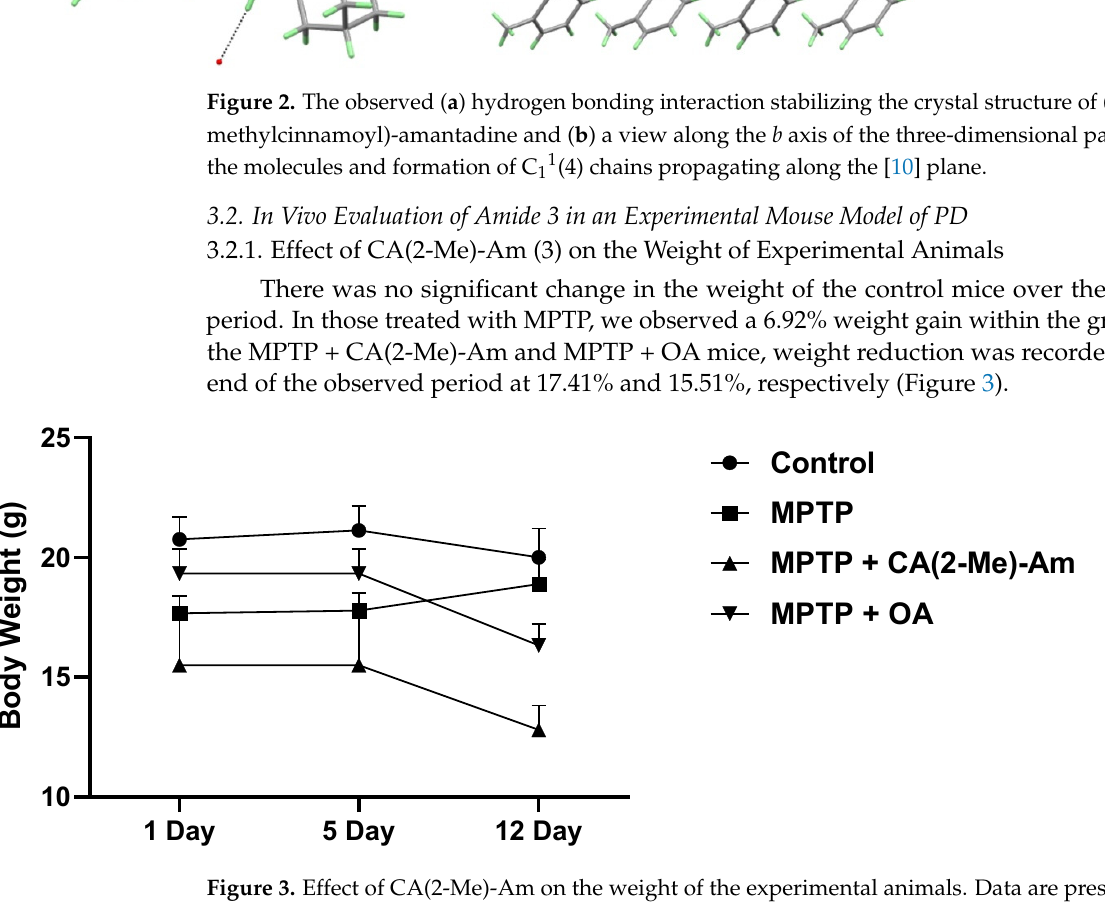
Figure 3. Effect of CA(2-Me)-Am on the weight of the experimental animals. Data are presented as means with their respective standard errors (m ± S.E.M; n = 8; * p < 0.05 ).